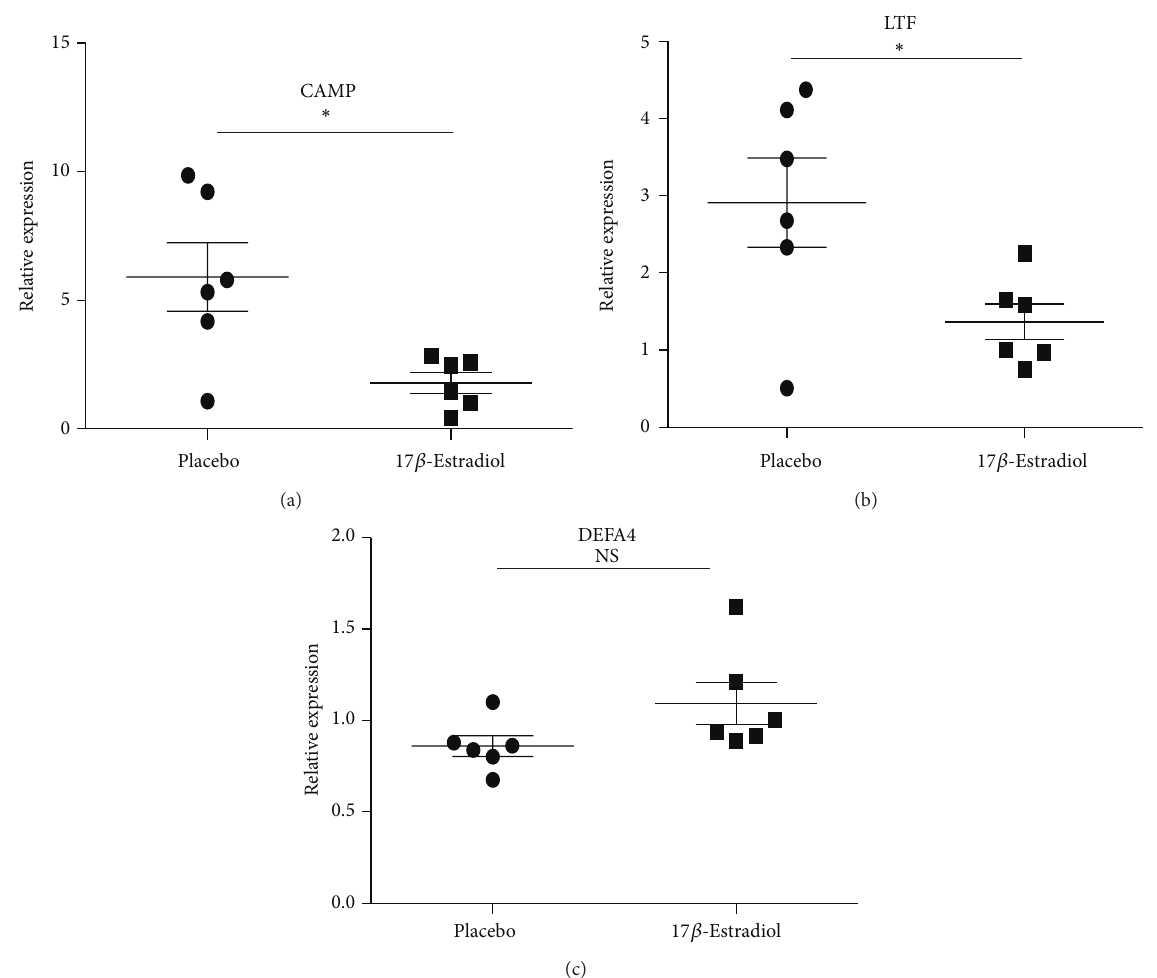
Figure 6: Expression levels of CAMP, LTF, and DEFA4 measured by qPCR in B cells from castrated and sham-castrated mice. B cells were purified from six male SLE patients and eight female SLE patients. Then the expression of CAMP, LTF, and DEFA4 was checked by qPCR. The data are presented as relative expression following normalization. Asterisks represent significant difference to the male ( ∗ 𝑃 < 0.05 ). NS: 𝑃 > 0.05